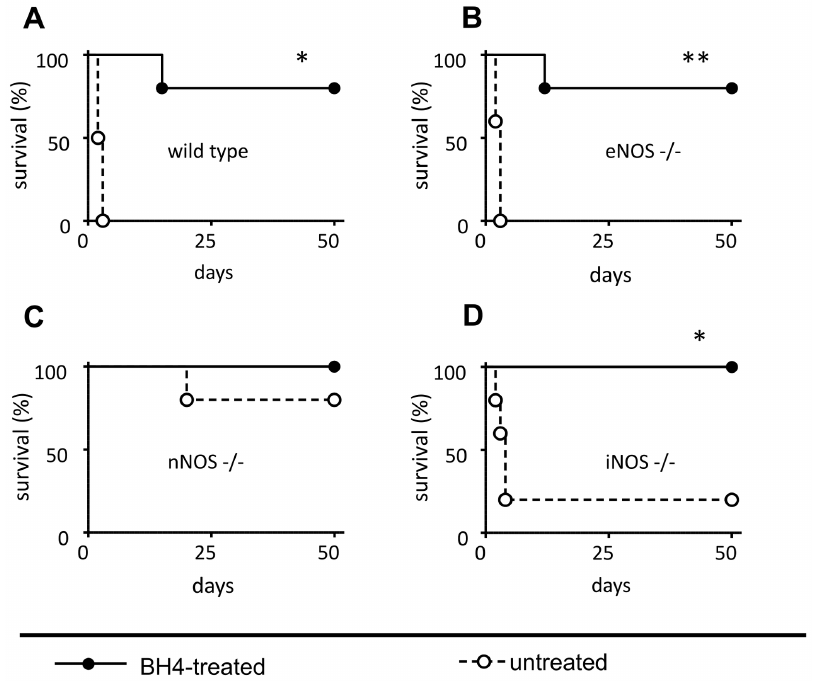
Figure 3. Dependence of recipient survival on donor genotype and treatment status. Pancreata were taken from BH4-treated or untreated donors with the indicated genotypes, subjected to ischemia, and transplanted to wt recipients of the same background as the knockouts. Survival of the animals was monitored for 50 days. Solid line, full circles: Donors treated with BH4. Dashed line, open circles: untreated donor animals. A: wt donors. B: eNOS 2 / 2 donors. C: nNOS 2 / 2 donors. D: iNOS 2 / 2 donors (n=5 per group). Asterisks indicate significant differences between recipients receiving either grafts from untreated or from BH4 treated donors of the same donor genotype: * p , 0.05, ** p , 0.01.